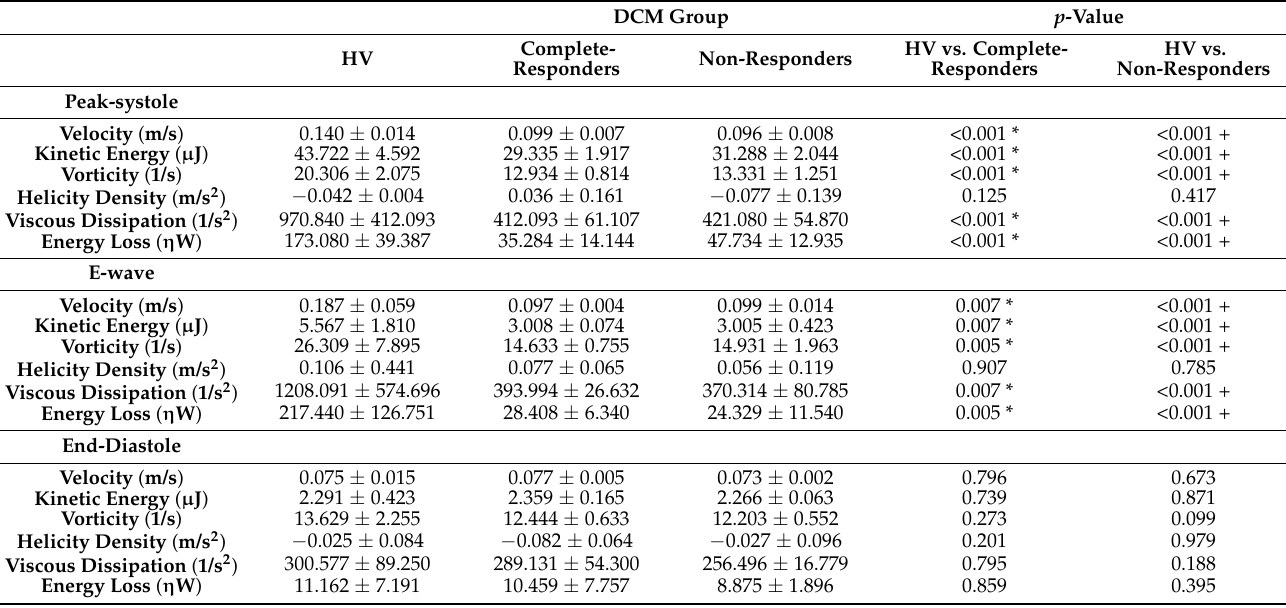
Table 2. Global hemodynamics data for HV, complete, and non-responders DCM patients. All quantitative data are expressed as the mean ± standard deviation. *,+ Indicates statistically significant differences ( p <